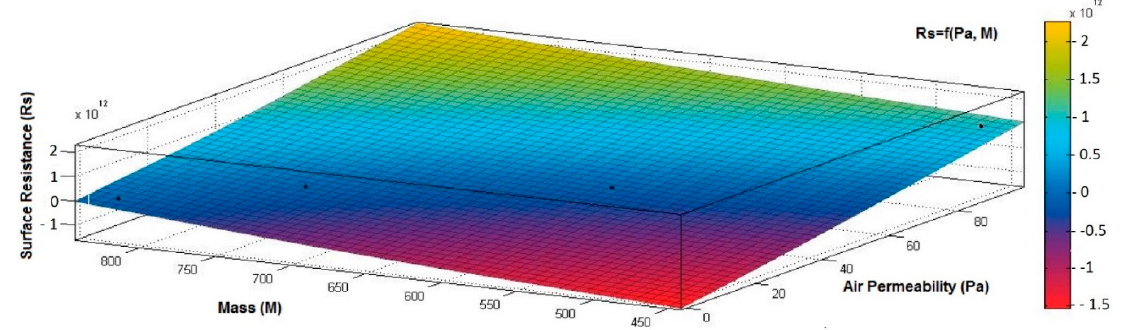
Figure 19. 3D representation Rs = f (M , Pa) samples coated with a conductive polymeric paste ‐ based PVDF.